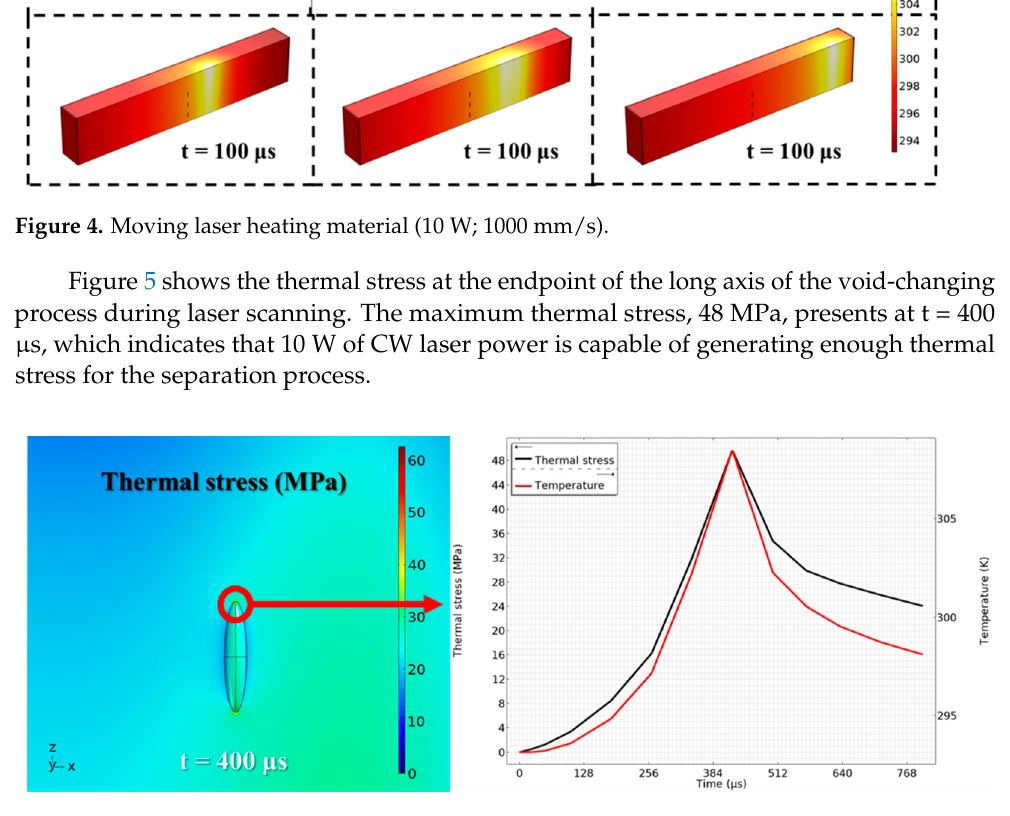
Figure 3. The diagram of the component structure with mesh.